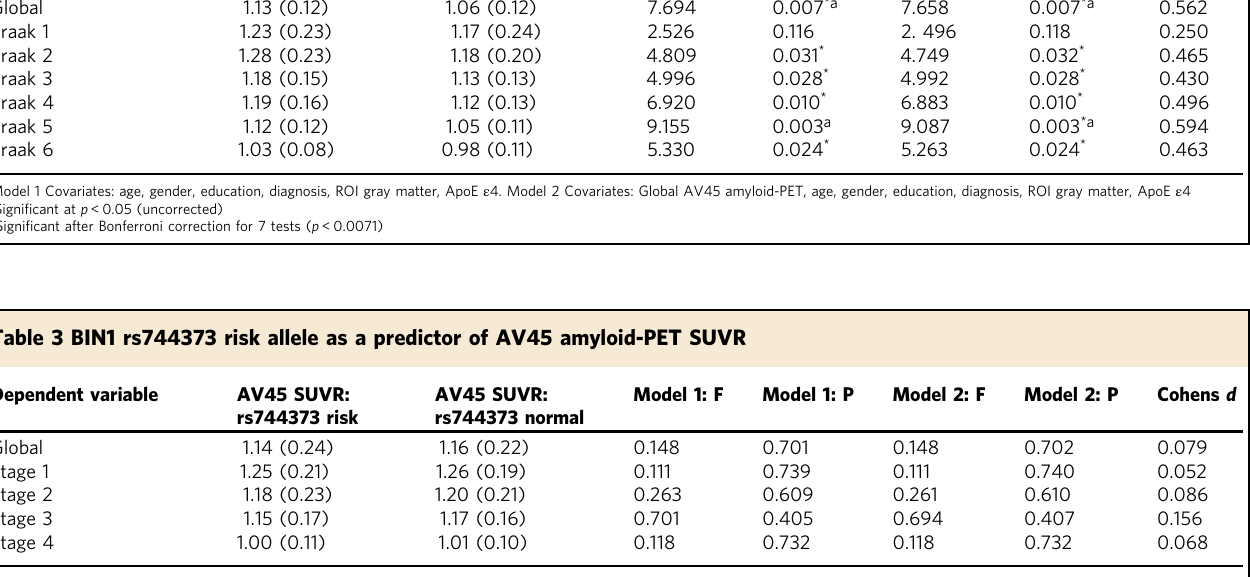
Model 1 Covariates: age, gender, education, diagnosis, ROI gray matter, ApoE ε 4. Model 2 Covariates: Global AV1451 tau-PET, age, gender, education, diagnosis, ROI gray matter, ApoE ε 4